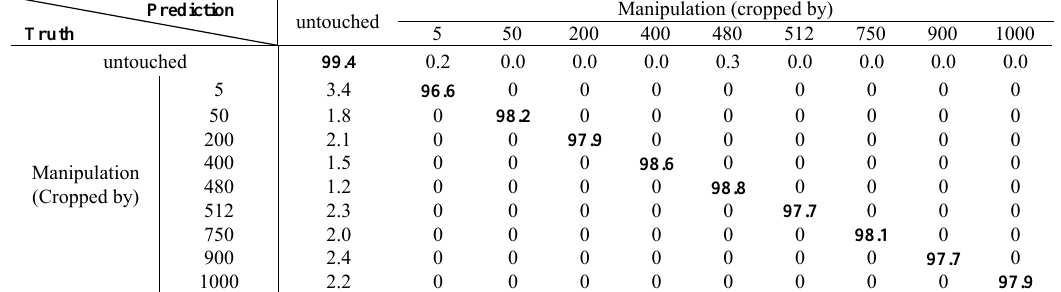
Table 1. Confusion matrix on testing sets (mean values, %) by using LibSVM with linear kernel over 100 experiments . Prediction Truth